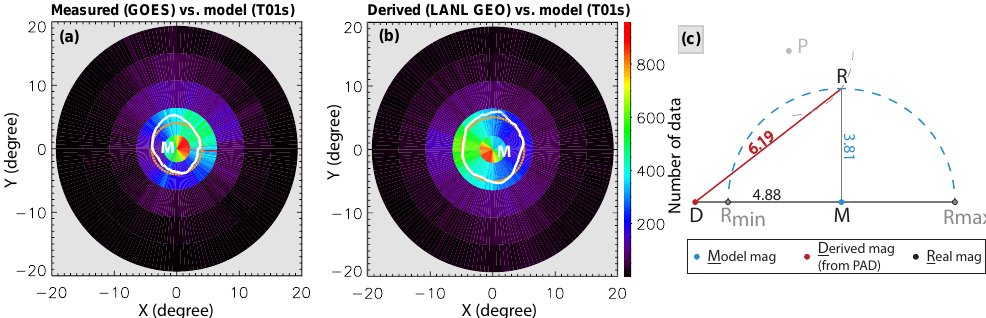
Figure 4. Deviation distributions and estimating the deviation angle range between derived and real magnetic field directions. (a) Distribu- tions of real directions ( R ) relative to model directions (marked by the white “M” in the origin pointing out of paper). The radial distance from any point to M is the deviation angle between a pair of model and real directions, and the azimuthal angle is determined in a modified local B -GSM coordinate system (and thus is not local time). Color in each bin indicates the count of data points. The overplotted white curve indicates the directional mean of deviation angles in each radial direction, compared to the red circle showing the mean of all deviation an- gles. (b) Distributions of derived directions ( D ) relative to model directions ( M ), directional means, and the mean circle in the same format. (c) Given averaged deviation angle values for DM (4.88 ◦ ) and RM (3.81 ◦ ) in Fig. 3, we may estimate that the range of DR is between [1.07 ◦ , 8.69 ◦ ], that is [0.28, 2.28] × DM . The imaginary point P and circle in gray, if available, will help pinpoint the position of R .